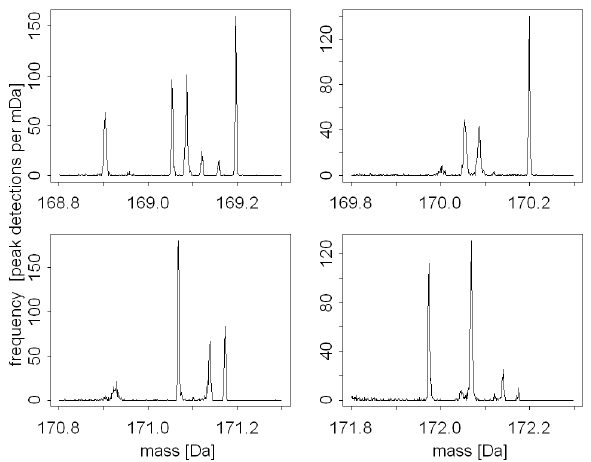
Figure C1. Peaks detected at nominal masses 169-172. The peak lists of all 1022 data files have Fig. C1. Peaks detected at nominal masses 169–172. The peak been evaluated. The x-axis is a bin-mass scale (1 mDa bin width); the y-axis gives the number lists of all 1022 data files have been evaluated. The x-axis is a bin- of files in which a peak was detected in the respective bin. The unified-peak-list was created mass scale (1mDa bin width); the y-axis gives the number of files in from this dataset. which a peak was detected in the respective bin. The unified-peak- list was created from this dataset.